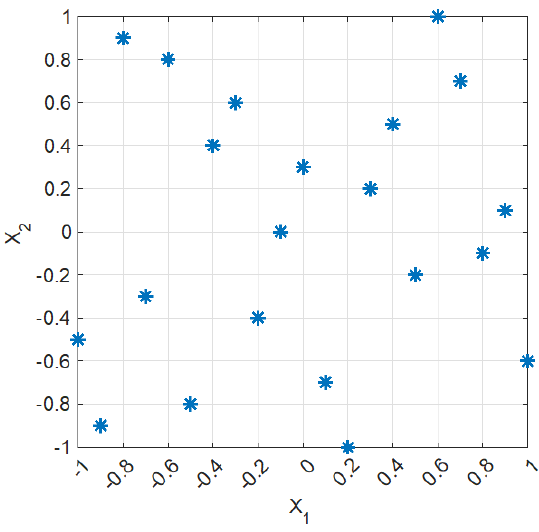
Figure 3. LHS − 2D space